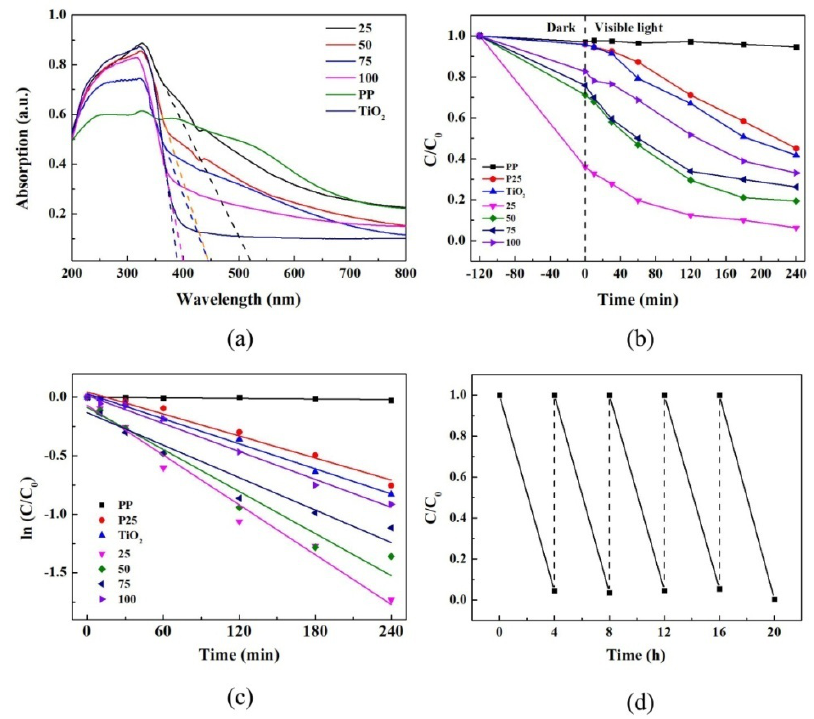
Figure 7. ( a ) UV–visible spectra; ( b ) the visible-light photocatalytic efficiency for rhodamine B; ( c ) plots of ln( C/C 0 ) versus irradiation time of PP, TiO 2 , and PP@TiO 2 nanospheres; ( d ) cyclic photocatalytic performance test of PP@TiO 2 -25 under visible-light irradiation.